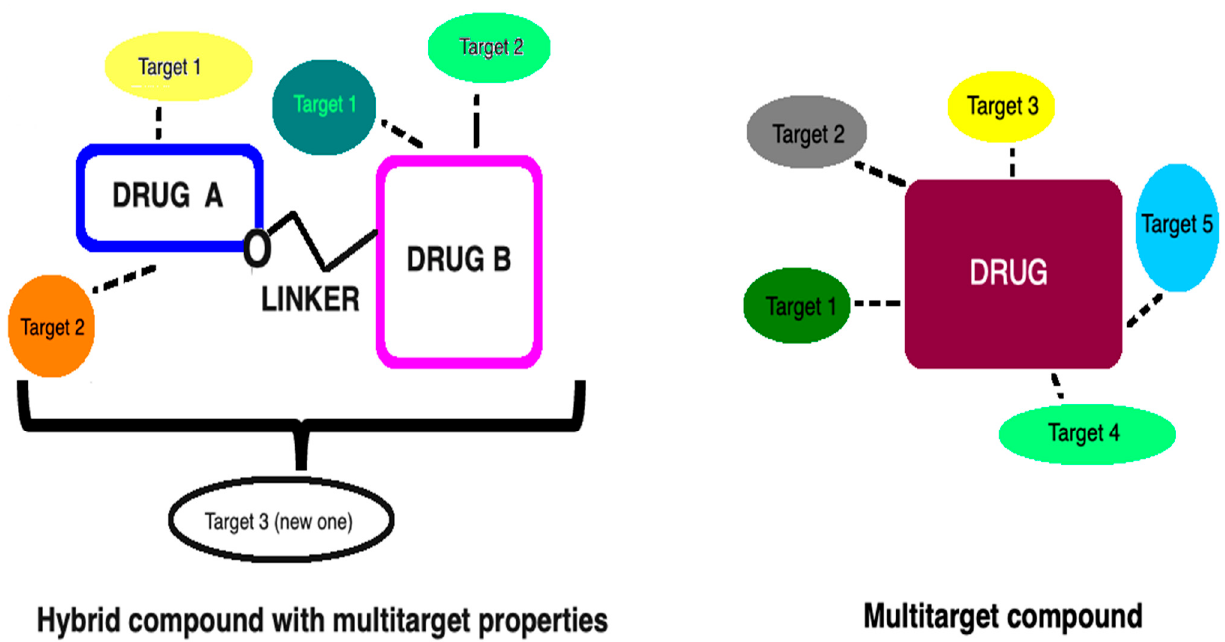
Figure 2. Comparison of multitarget compounds vs. hybrid compounds with multitarget properties. Multitarget compounds that are not bivalent hybrid molecules do not possess specific building fragments corresponding to original drugs or other known ligands. On the other hand, they are characterized by having recognized and privileged small fragments/regions that are able to target different systems (e.g., heterocyclic cores, aliphatic residues). In contrast, hybrid compounds encompass one or more bioactive compounds from a different class or their pharmacophoric subunits (drug A, drug B) into one molecule, thereby representing the desired features of the original drugs. In the figure, the hybrid structure is built on the basis of a conjugation of pharmacophores connected via any cleavable linker (e.g., esters, amides, carbamates, or disulfide